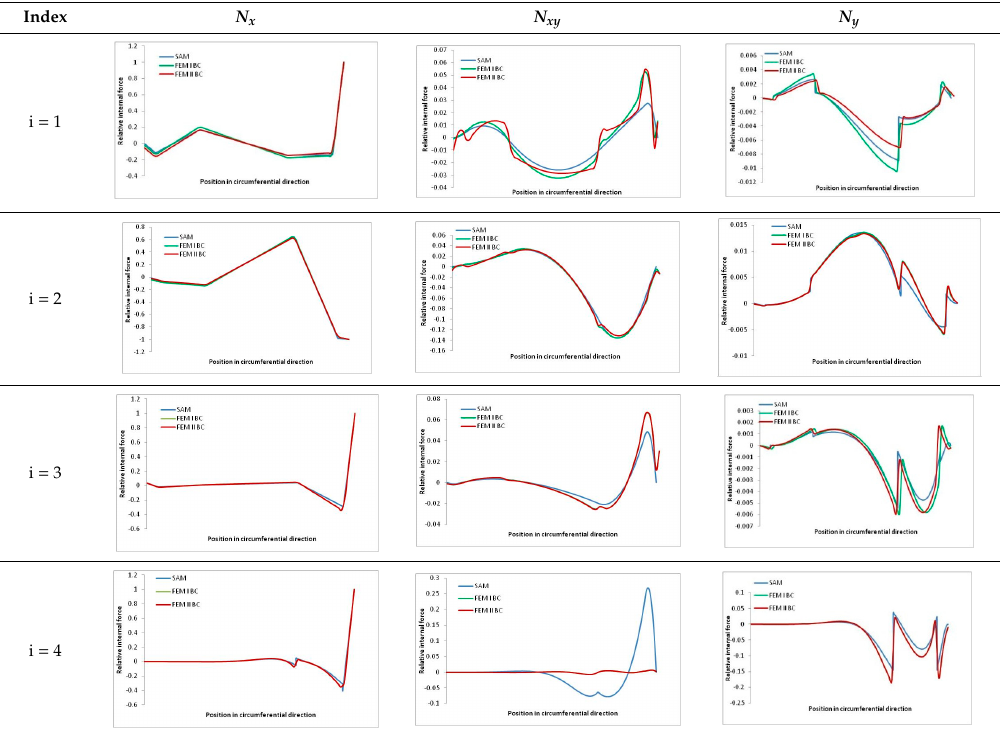
Table 7. The distribution of internal forces N x , N y and N xy for the LC–1 beam.